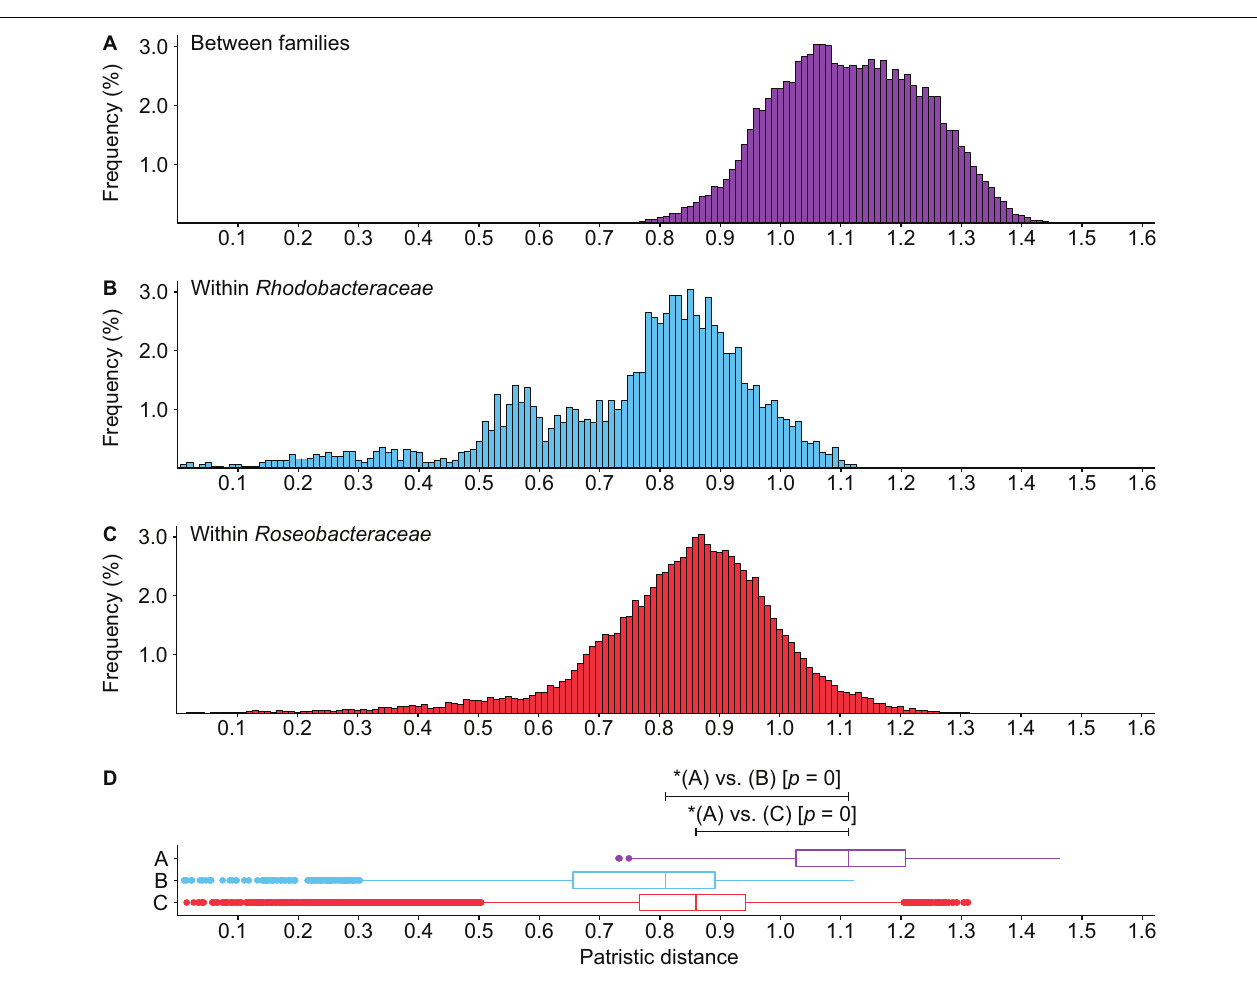
FIGURE 6 | Histogram of patristic distance for comparisons (A) between Roseobacteraceae fam. nov. and Rhodobacteraceae (purple), (B) within Rhodobacteraceae only (blue), or (C) within Roseobacteraceae fam. nov. only (red). (D) Box plots show the 1.5 interquartile range, 25th, 50th, and 75th percentile. Asterisks (*) indicate significant differences between distributions ( p <